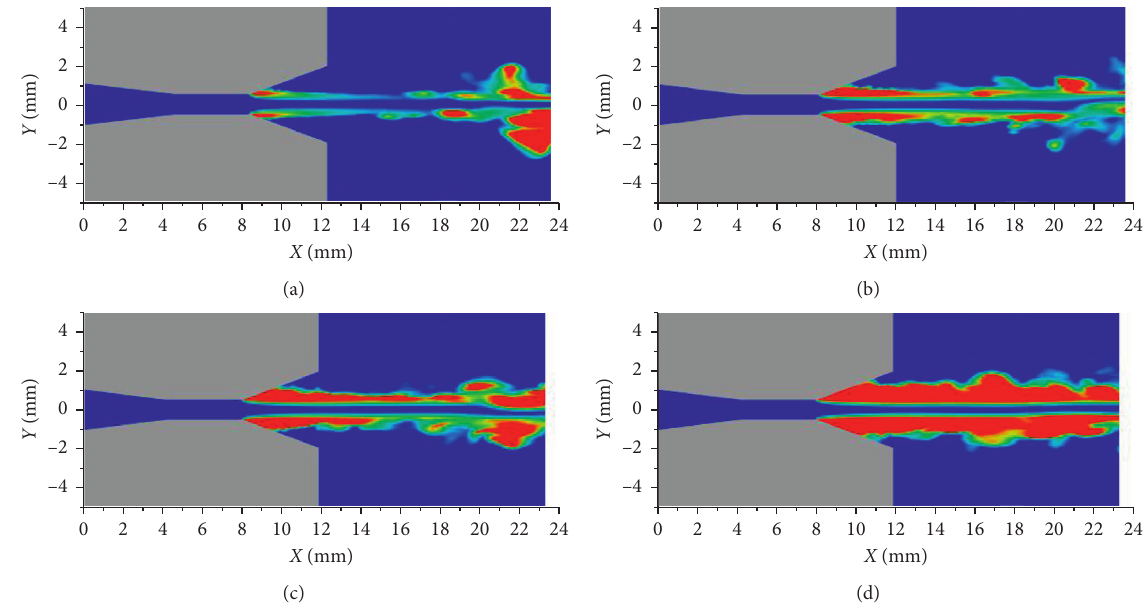
Figure 14: Vapor volume fraction under different cavitation numbers. (a) σ � 0.0203. (b) σ � 0.0101. (c) σ � 0.0068. (d) σ �